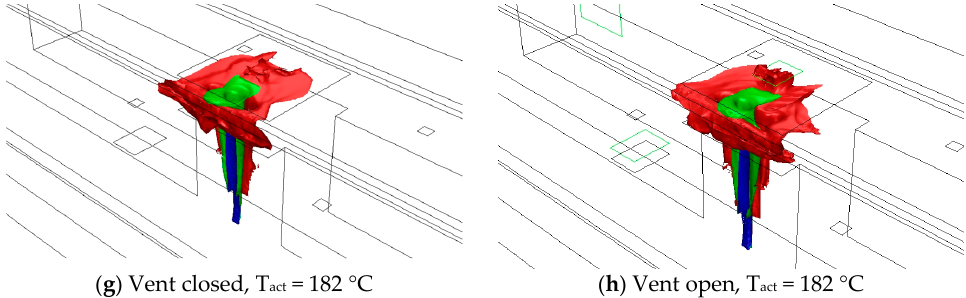
Figure 5. 3D sprinkler activation time maps—iso-surfaces of sprinkler activation in 60 s (red), 120 s (green), and 180 s (blue) from the ignition of the fire. Calculations for fire scenario 2, and the domain area shown in Figure 3.